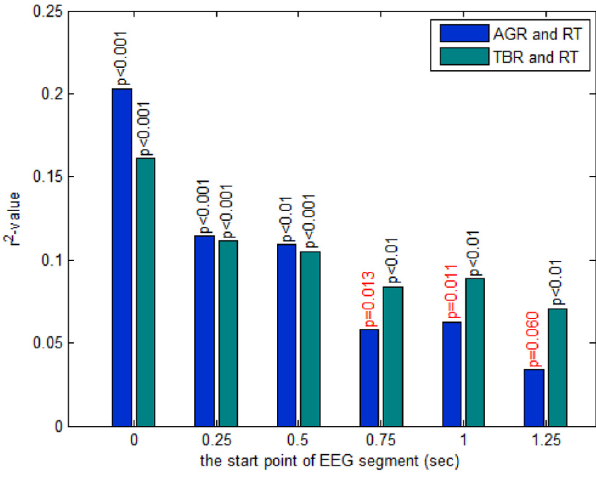
Figure 5. Correlation coef fi cients between AGR/TBR and RT against the start point of EEG segment with reference to cue onset for a fi xed segment length of